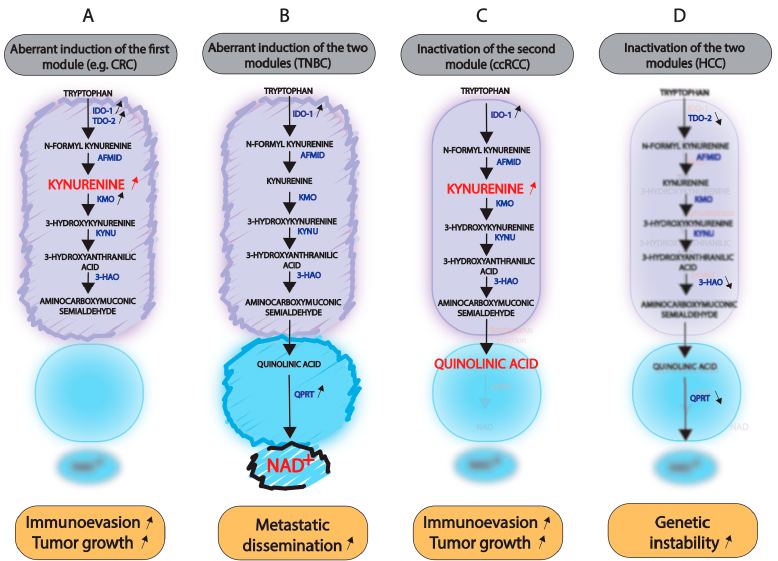
Figure 3. Different outcomes of kynurenine pathway alterations in cancer. Panel ( A ): the aberrant induction of the first module, as observed in colorectal carcinomas (CRC), leads to the accumulation of kynurenine, thereby promoting tumor growth and immune evasion. Panel ( B ): aberrant induction of the two modules, as observed in triple-negative breast cancers (TNBC), fuels cells with NAD + and promotes cancer cell dissemination. Panel ( C ): Inactivation of the second module, as observed in clear cell renal cell carcinoma (ccRCC), leads to the accumulation of quinolinic acid and favors tumor development. ( D ): Inactivation of both modules, as observed in hepatomacarcinomas, prevents NAD + production, favors genomic instability and, thereby, tumor development.